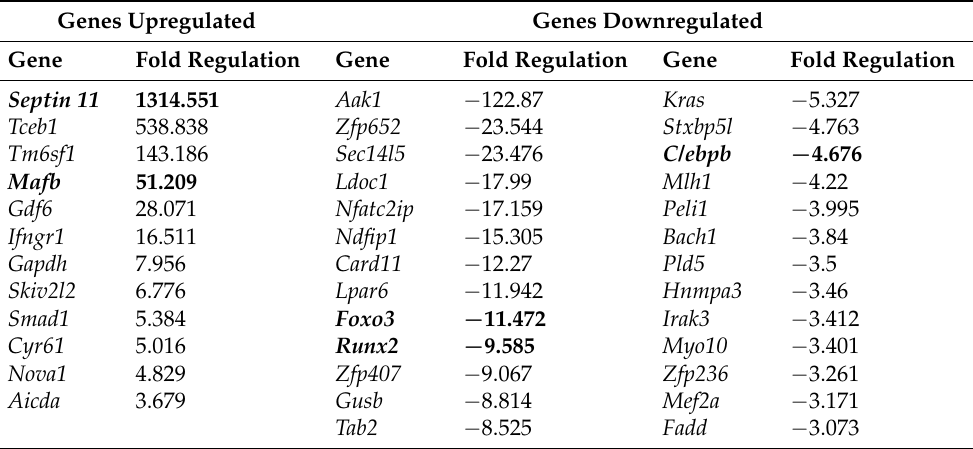
Table 3. Expression of miR-155 target genes in cortical samples from 3-month-old 3xTg-AD mice vs. respective wild-type (WT) animals. Genes Upregulated Genes